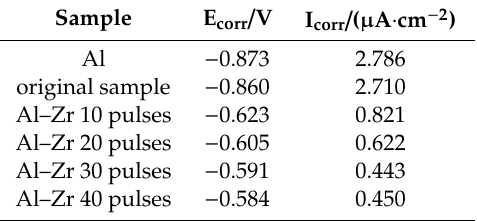
Figure 8. Corrosion polarization curves of pure Al and samples before and after HCPEB irradiation. Table 1. The corrosion data of the alloyed Al–Zr and unalloyed pure Al samples.